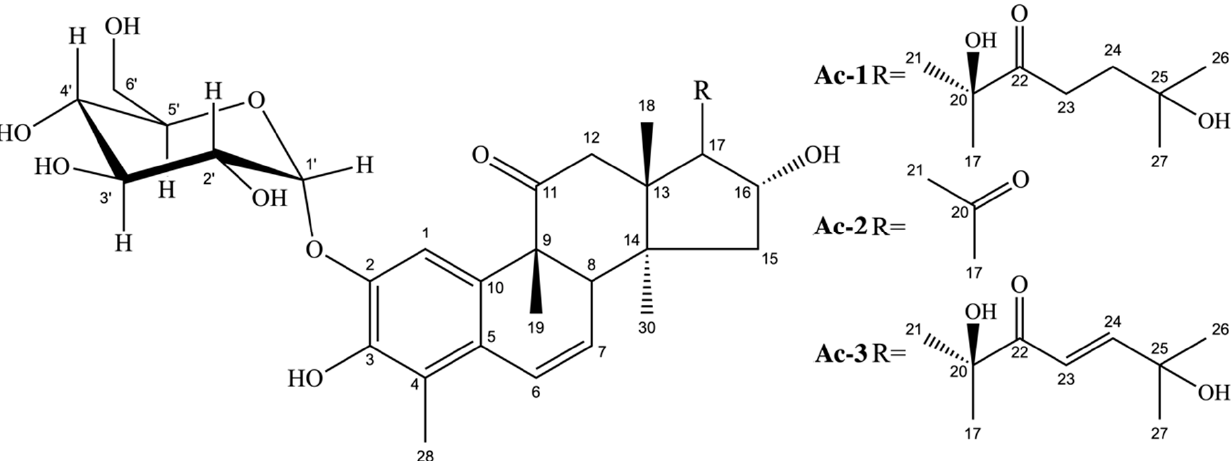
Figure 1. Chemical structures of cayaponoside C 5b (Ac-1), cabenoside C (Ac-2) and fevicordin C 2 glucoside (Ac-3).